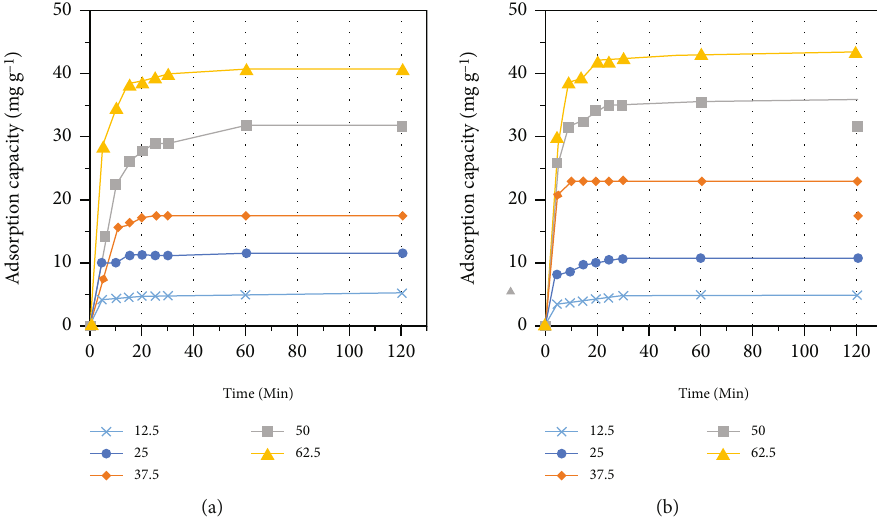
Figure 3: Adsorption capacity of (a) 1CPC and (b) 1HDTMA in a time- and concentration-dependent manner. The adsorption conditions included an initial Cr(VI) concentration of 12.5 – 62.5mgL -1 , adsorbent weight of 0.1g, contact time of 0 – 120min, and temperature of 25 °